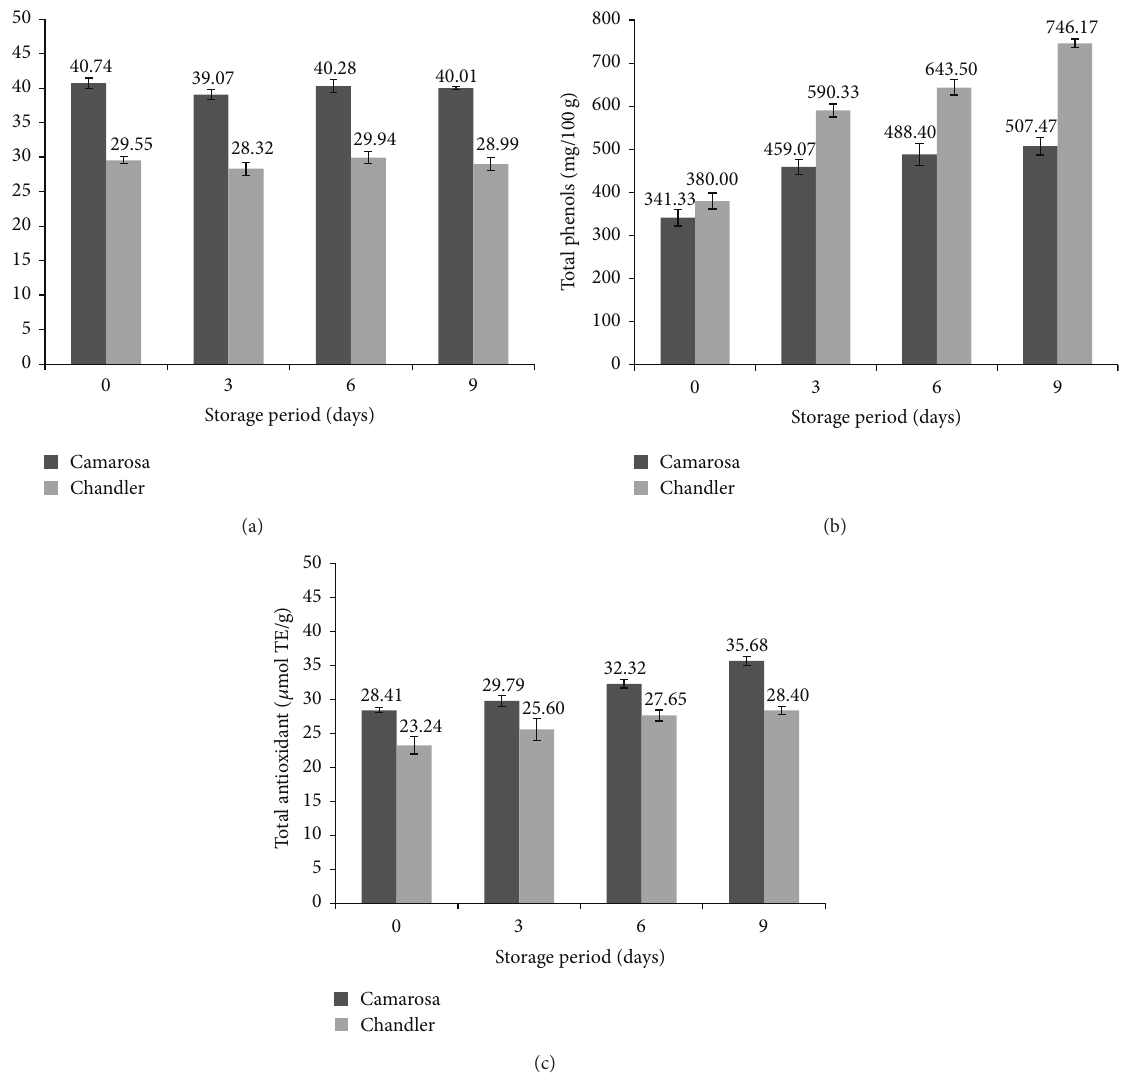
Figure 2: Changes in (a) total anthocyanin content, (b) total phenols, and (c) Total antioxidants of strawberry (Camarosa and Chandler) during storage at 5 ∘